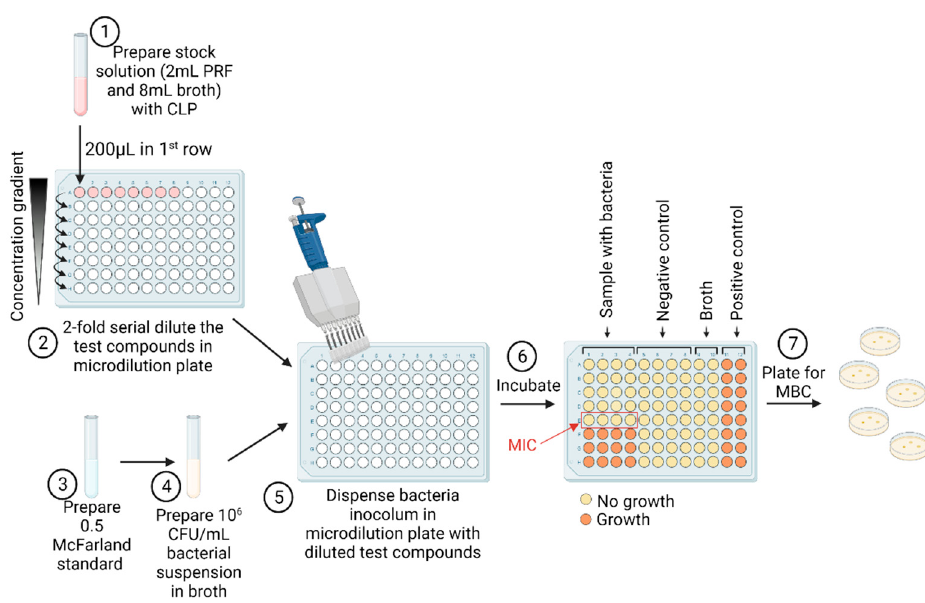
Figure 10. The MIC/MBC assay of CLP, PRF and PRF_CLP samples. Figure created with Bioren- der.com.